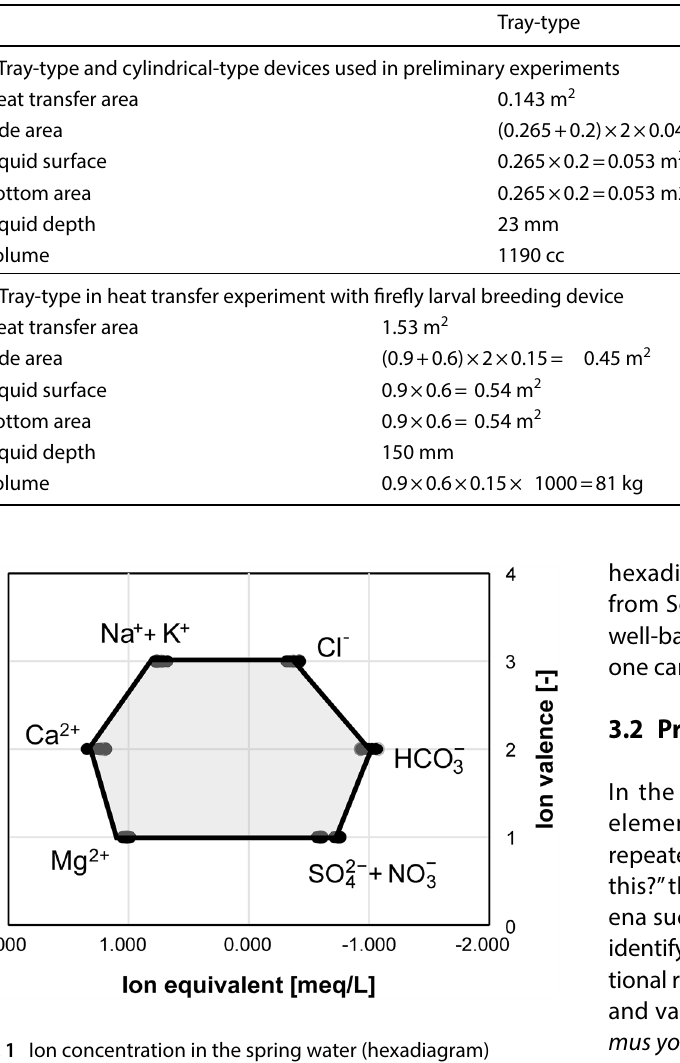
Fig. 1 Ion concentration in the spring water